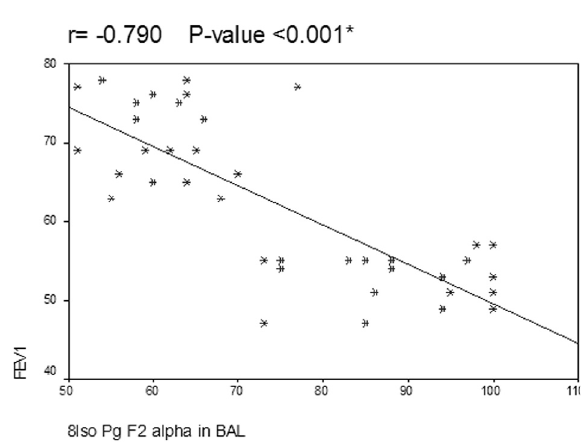
Diagnostic value of 8-iso-PGF2 α and TGF β 1 Frahat et al.